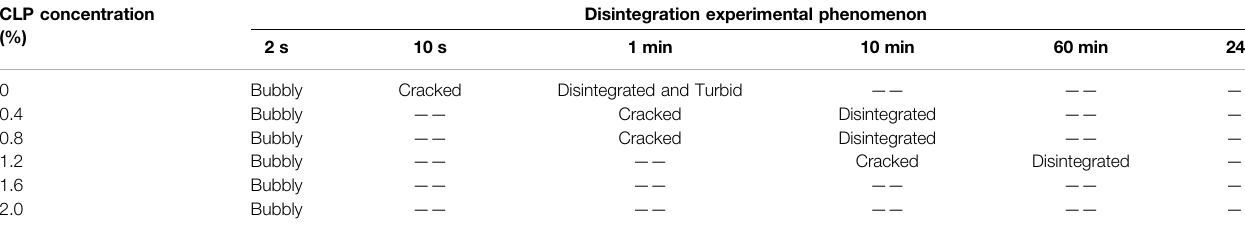
—— indicates no signi fi cant changes were observed.